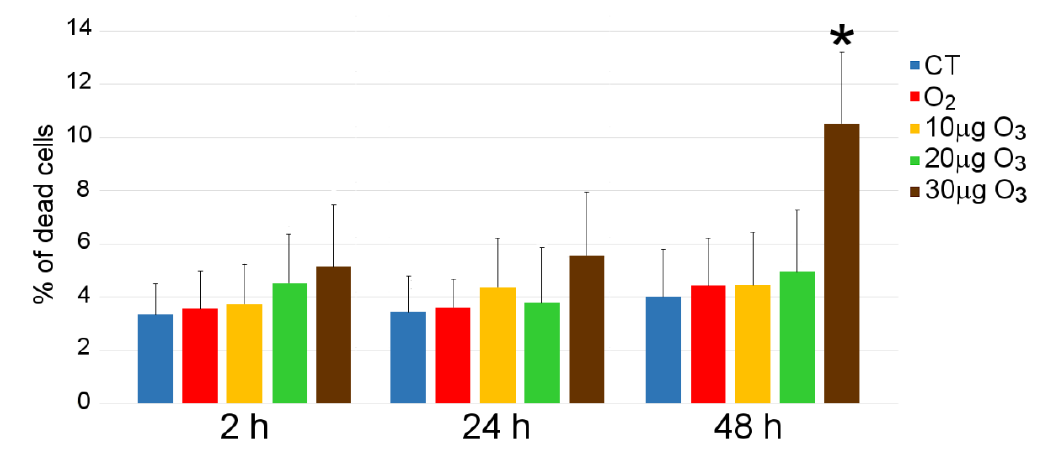
Figure 7. Diagrams show the mean value ± SD of percentage of dead cells in the PHA/PMA activated-cells samples after 2 h, 24 h, and 48 h from gas treatment. The asterisk (*) indicates significant difference with the respective control (CT). After activation with PHA/PMA, the number of Jurkat cells did not change, apart from the sample treated with 30 µg O 3 , where cell population significantly decreased after 48 h (Figure 8).